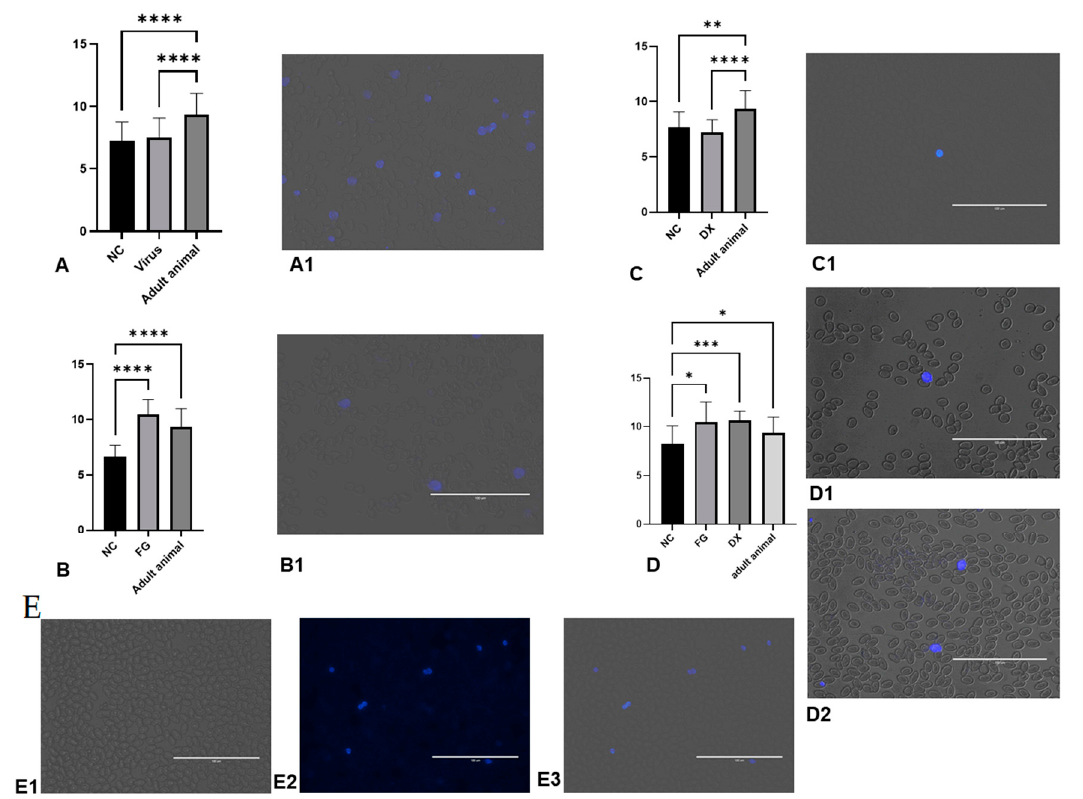
Figure 5. Diameter of formalin-labelled thrombocytes evaluated. ( A ) diameter of thrombocytes in SPF CE inoculated with Gammacoronavirus . ( A1 ) thrombocytes stained in group treated with virus. ( B ) Diameter of thrombocytes in CE treated with filgrastim at 10 EID. ( B1 ) thrombocytes stained in group treated with FG inoculated at 10 EID via CAM. ( C ) Diameter of thrombocytes in CE treated with DX inoculated at 10 EID via SM. ( C1 ) thrombocytes stained in the group treated with DX. ( D ) Diameter of thrombocytes in CE treated with FG and DX inoculated at 12 EID via SM. ( D1 ) thrombocytes stained in the group treated with FG. ( D2 ) thrombocytes stained in the group treated with DX. ( E ) Thrombocytes stained in the NC group in CE inoculated at 10 EID. ( E1 ) trans, ( E2 ) UV, ( E3 ) over. The asterisks symbols indicate a statistical difference between the groups (* = p ≤ 0.05; ** = p ≤ 0.01; *** = p ≤ 0.001; **** = p ≤ 0.0001). NC: Negative control. Scale bar = 100 µm.